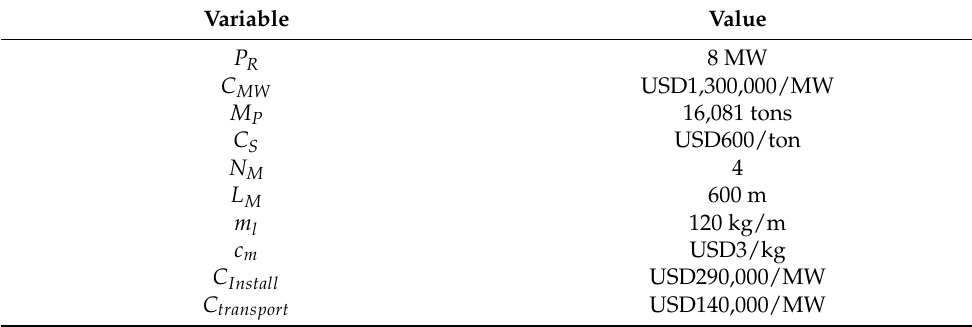
Table 10. Parameters considered for the